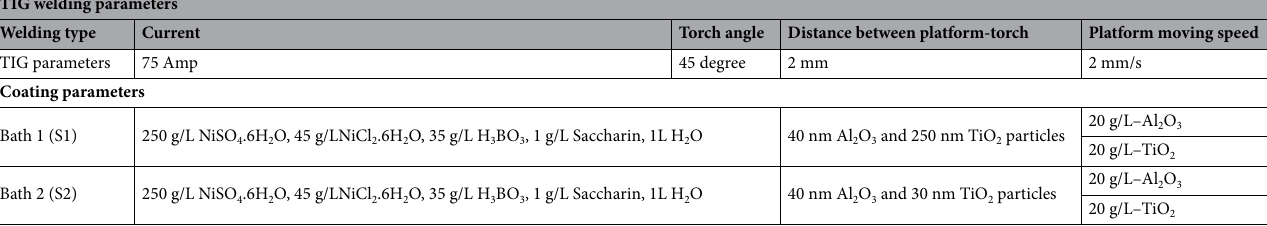
Table 1. Parameter setting for the TIG process used to melt the surface of the Titanium alloy.